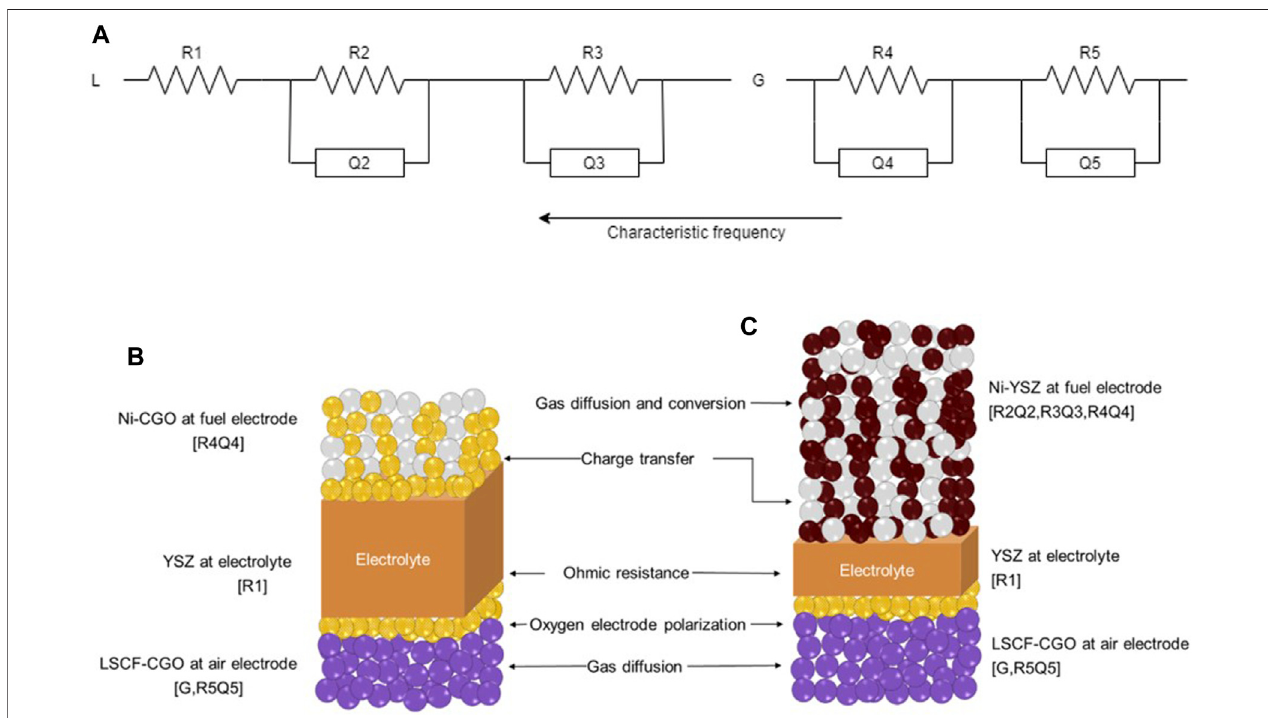
FIGURE4| ECMusedfortheCNLS fi tofrecordedimpedancedata (A) ,movingfromthelowestfrequency(R5Q5)tothehighestone(L)andtheirattributiontoeach cell layer for ESC (B) and ASC (C) con fi gurations.